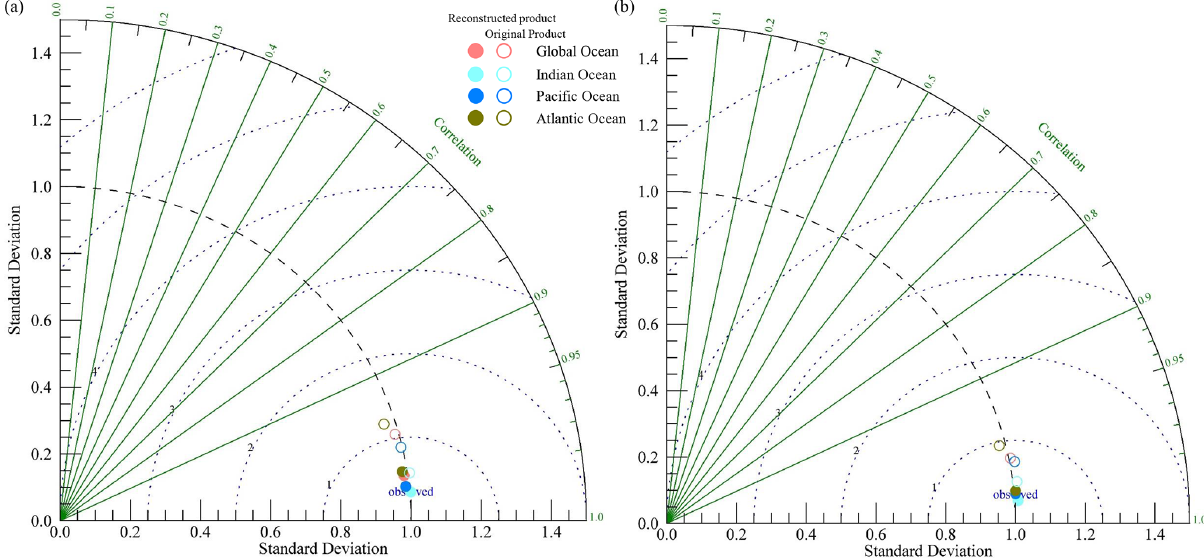
Figure 16. Normalized Taylor diagrams showing differences between matched SST from in situ data before (a) and after (b) correction and the corresponding SST